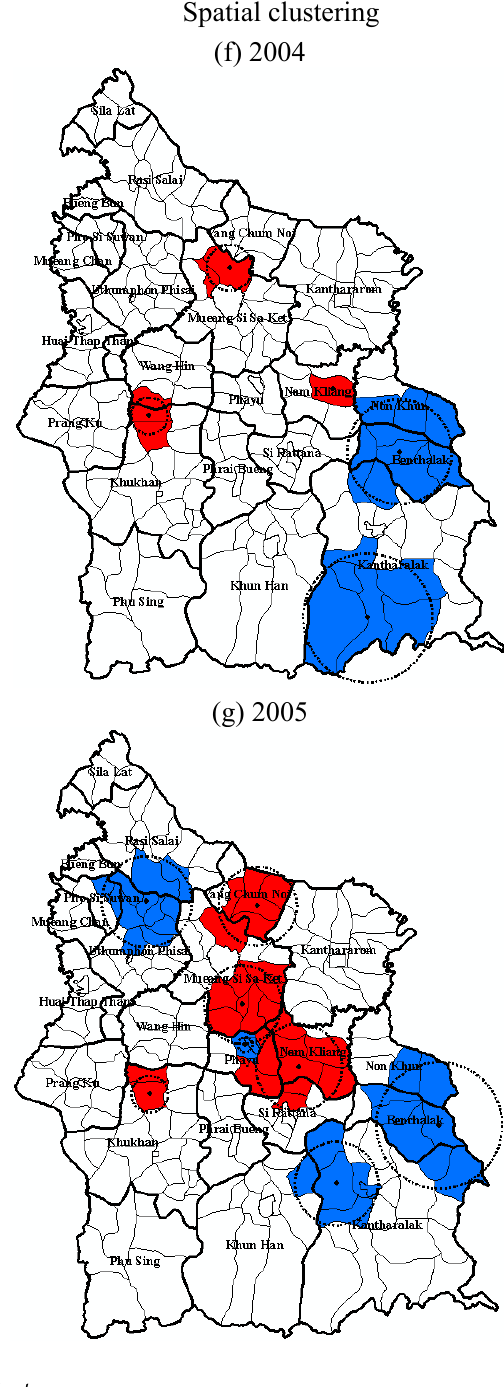
Figure 5. Cont. Figure 5.